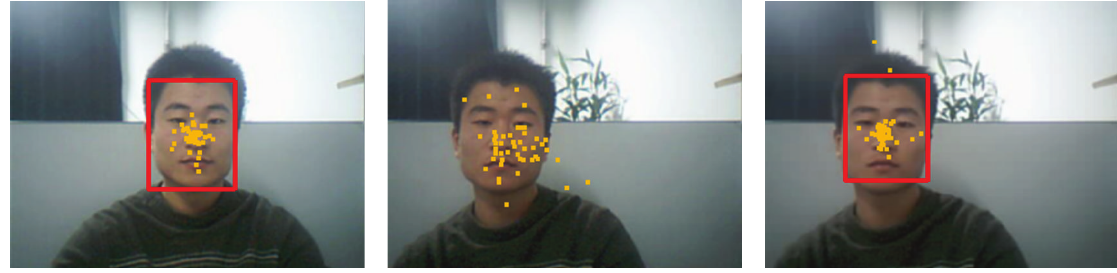
Figure 9: Object tracking by multiagent